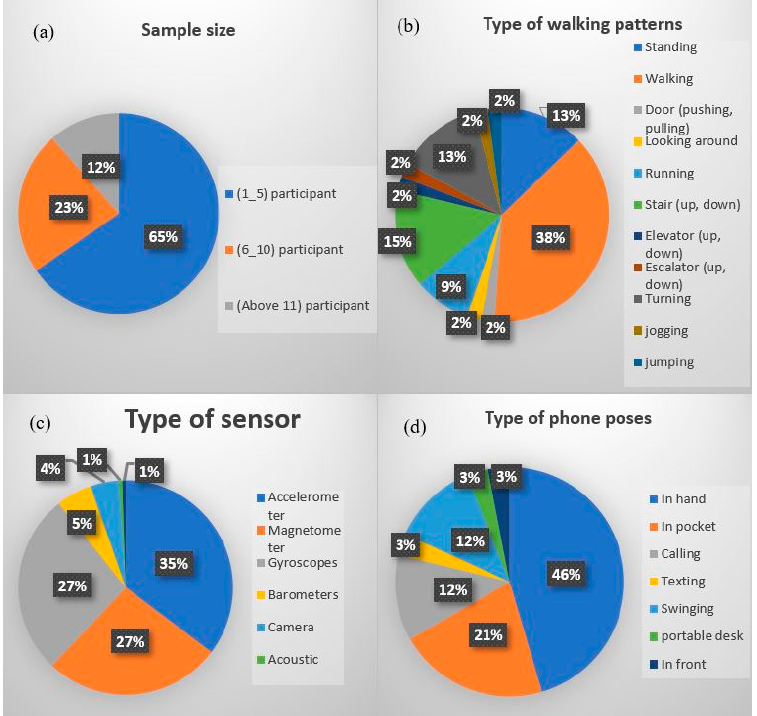
Figure 4. Percentage of aspects identi fi ed in past studies: ( a ) sample size, ( b ) walking pa tt erns, ( c ) sensor types, and ( d ) phone poses.